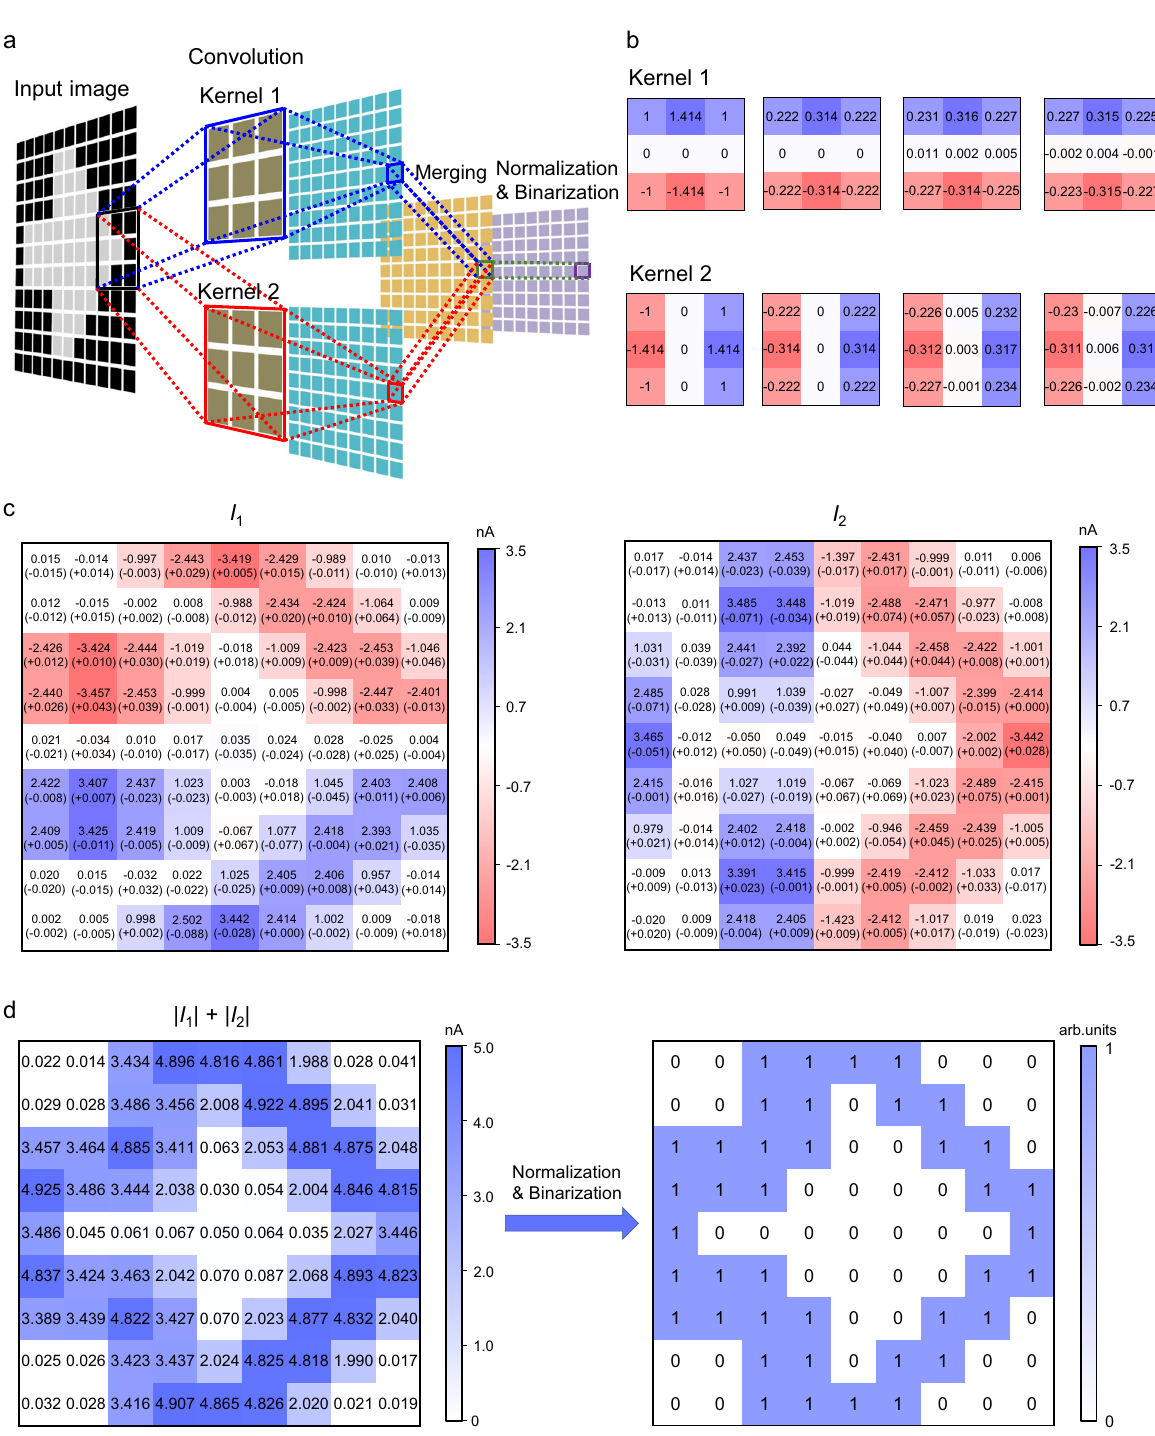
Fig. 6 Implementation of edge detection. a Schematic illustration of the operations for the edge detection. The convolution is implemented by sequentially presenting the sub-images whose pixel values are translated to the illumination signals to the kernels based on FE-PS-NET. The merging, normalization, and binarization of output currents are performed in software. b From left to right: theoretical dimensionless weights, theoretical photoresonsivities scaled from dimensionless weights, actual weights right after programming, and actual photoresonsivities after edge detection, for Kernel 1 and 2. The unit of photoresponsivity is mA/W (not shown). c Output currents I 1 (left panel) and I 2 (right panel) after the convolution with the two kernels. The values outside the brackets are the actual I 1 and I 2 values while those in the brackets are the differences between the theoretical I 1 and I 2 values and their corresponding actual values. d Image obtained by merging I 1 and I 2 (left panel) and fi nal output image after normalization and binarization showing the detected edge (right